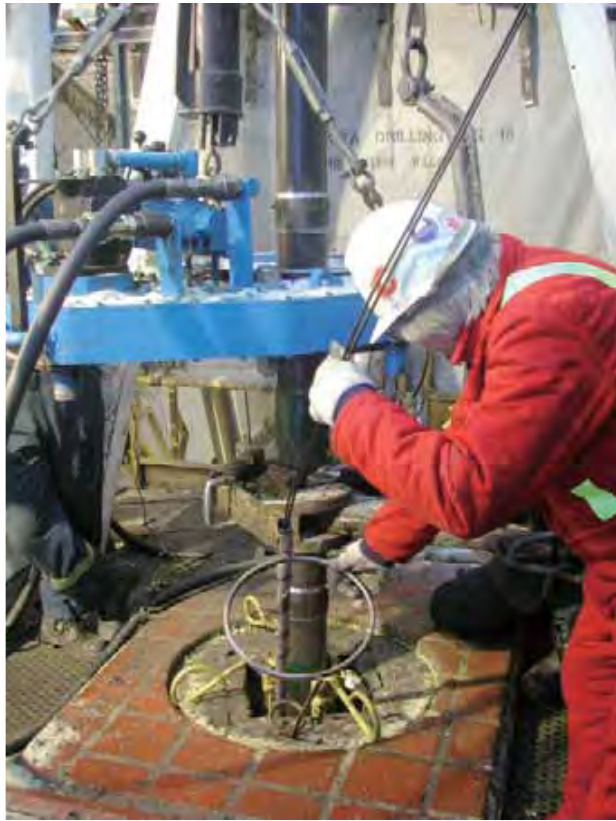
Figure 1. Distributed Temperature Profiling (DTS) fiber-optic cable installation for permanent temperature surveys behind the casing at Mallik Gas Hydrate drilling site in Canada. Fiber-optic cables are attached to the outside of the casing wall by special cable clamps to prevent cable damage while running into the hole.Special cable outlet connectors at the well head ensure safe data retrieval from the cemented borehole annulus to the